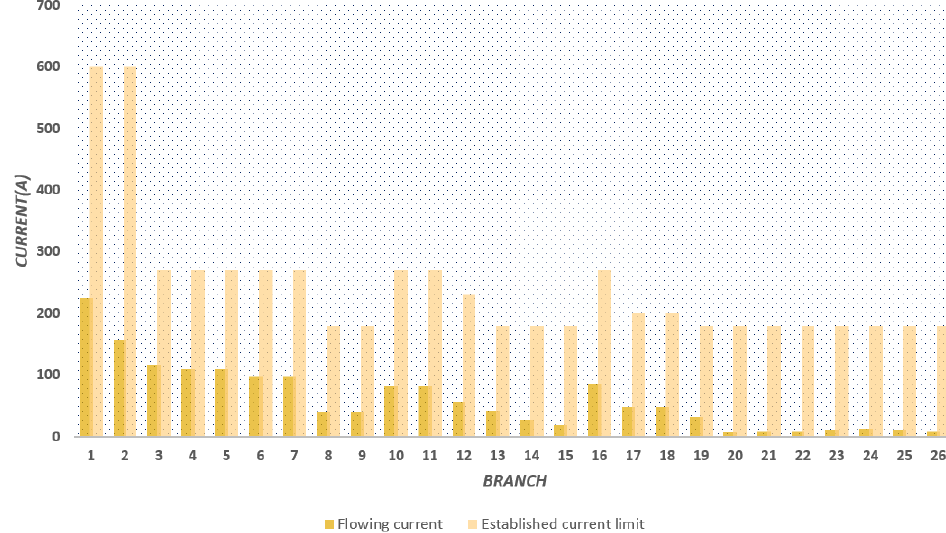
Figure 17. Loadability levels present in the branches of the three-phase 27-bus distribution system under an unbalanced load